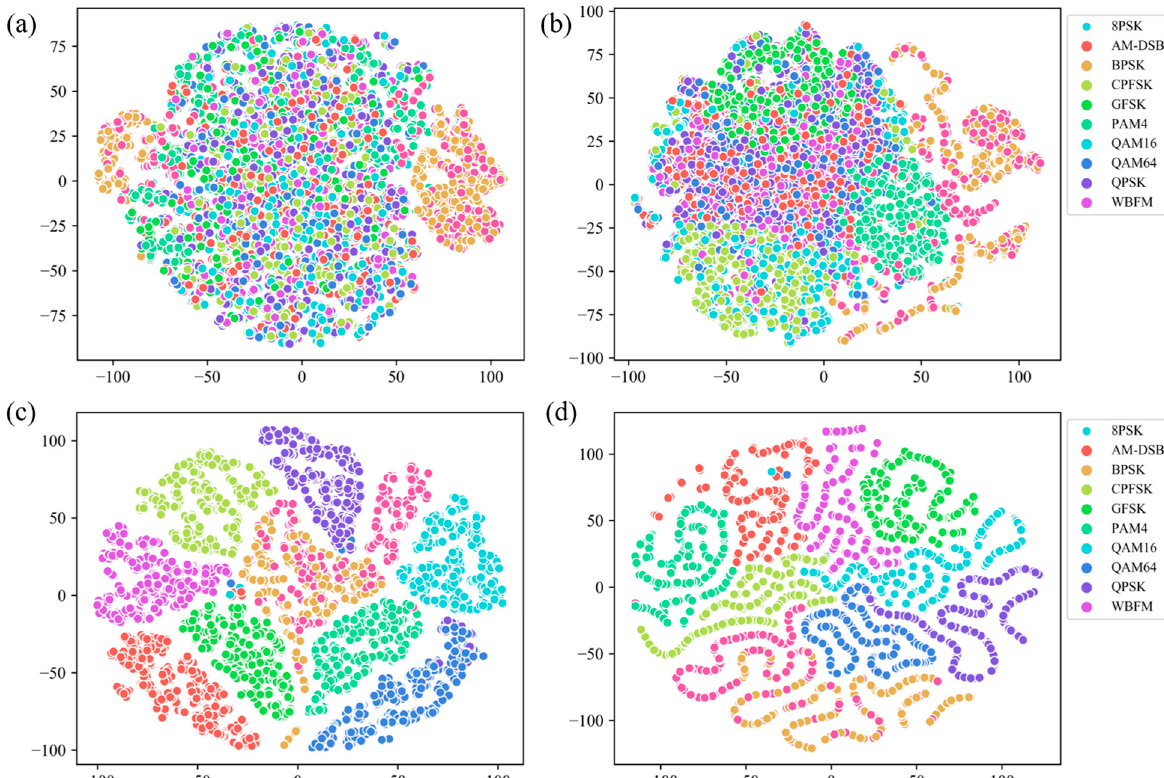
Figure 9. T-SNE data visualization distribution of 10 modulated signals. ( a ) Raw data distribution; ( b ) layer 11 (CNN) output; ( c ) layer 14 (LSTM) output; ( d ) layer 18 (SoftMax) output.